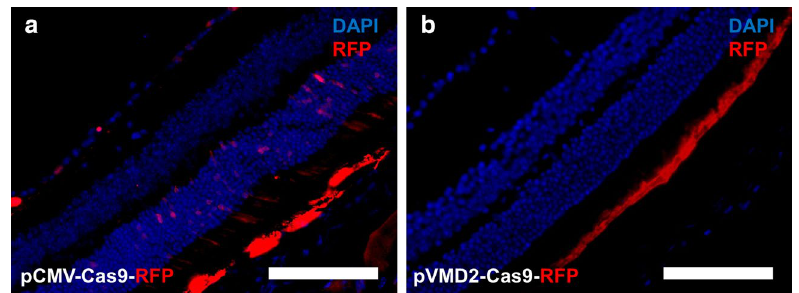
Figure 2. Expression patterns of pCMV-SpCas9-RFP and pVMD2-SpCas9-RFP in mice. ( a ) The pCMV vector expressed RFP both in the RPE and neural retina; ( b ) whereas the pVMD2 vector expressed RFP only in RPE (Scale bar = 100